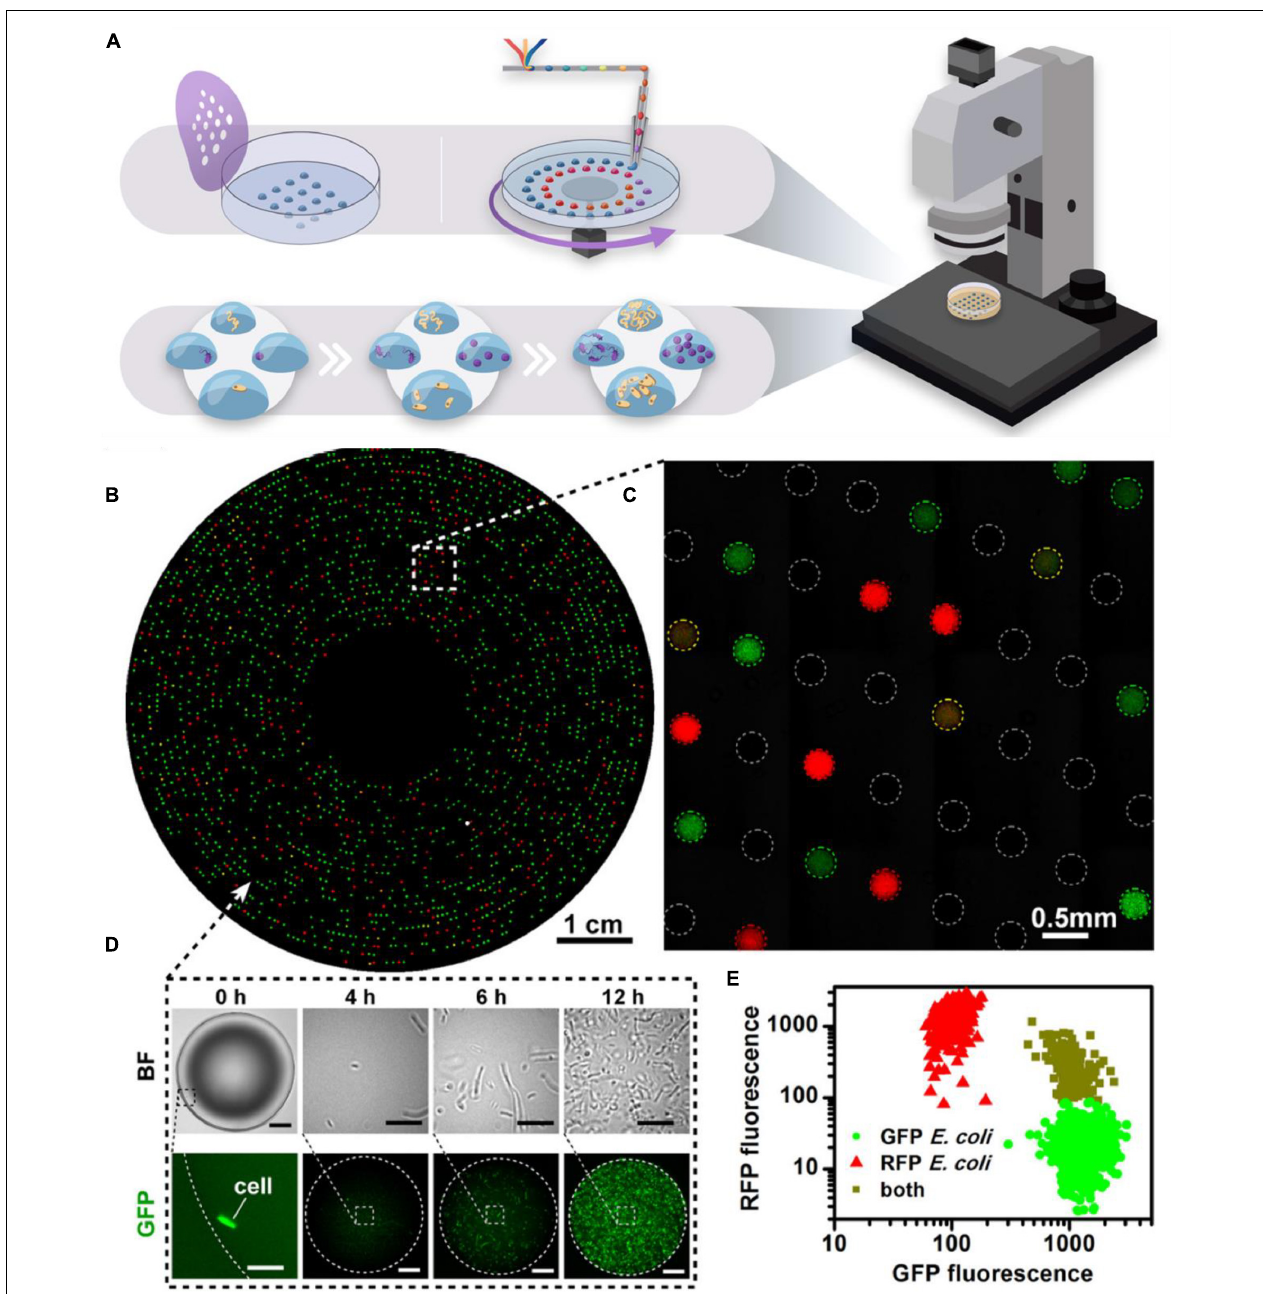
FIGURE 2 | Microarray technology. (A) Microarrays may be stamped or written onto Petri dishes with a microfluidic pen. The hydrophilic droplets containing the cell inoculum are immersed under mineral oil to prevent evaporation and droplet coalescence. Dilution-to-extinction results in compartmentalization of the cells, such that there is one cell per droplet. Competition of resources is negated, allowing slow growers to not be outcompeted. The array is highly amenable to automated screening under a microscope. (B–E) Microfluidic Streak Plate demonstrating isolation and cultivation of bacterial cells from a mixed consortium of RFP- and GFP-tagged E. coli. Cells can be imaged in real-time (D) to show growth dynamics within a single droplet and relative growth (E) of each species can be observed by quantifying fluorescence intensity of each species. Reproduced with permission (Jiang et al., 2016). Copyright 2016, American Society for